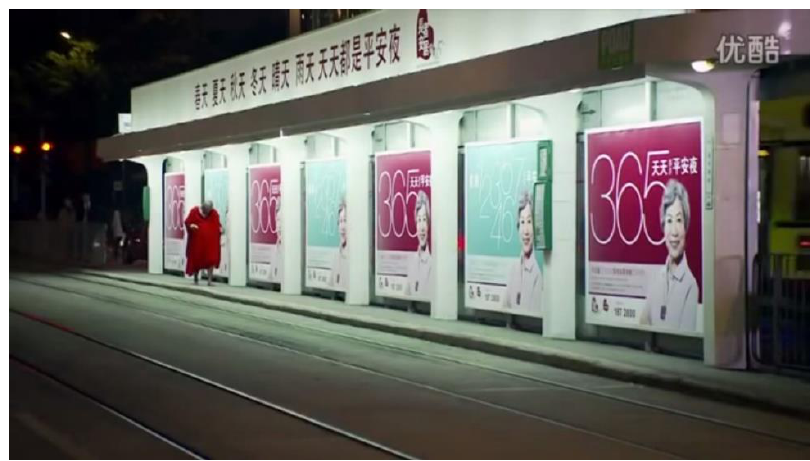
Figure 4. Spring, summer, autumn or winter, rain or shine—every day can bring a peaceful night.